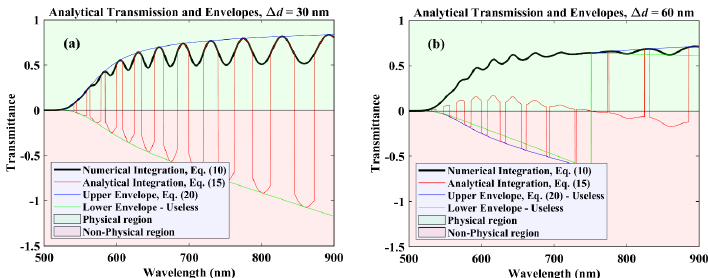
Figure 3. Numerical integration of Equation (6) for transmission, and the upper and lower envelopes, for ( a ) Δ d = 30 nm, and for ( b ) Δ d = 6 0 nm (see the text for more details).